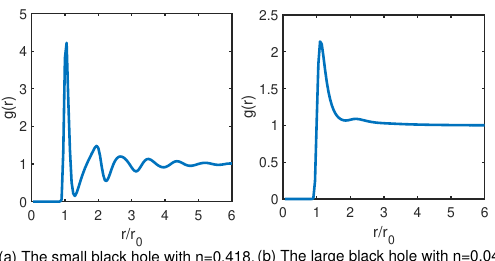
Figure 5 . The radial distribution functions g ( r ) of the small and large black holes at T = 0 . 5 T c and P = 0 . 1955 P c . When the small black hole crosses the coexistence curve to become the large black hole, there is a sudden change of the mesoscopic structure from subfigure ( a ) (left) to subfigure ( b )